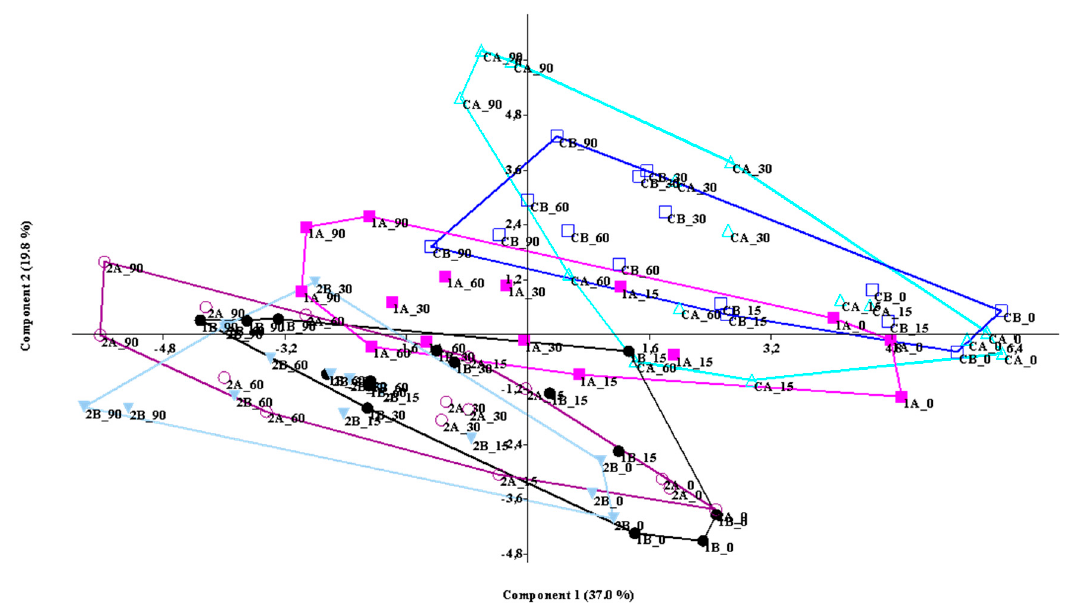
Figure 1. Principal component analysis (PCA) scatter diagram defined by the first two principal components (i.e., PC1, PC2) and convex hulls for the measured physico-chemical and textural traits of the breads, grouped by storage time.